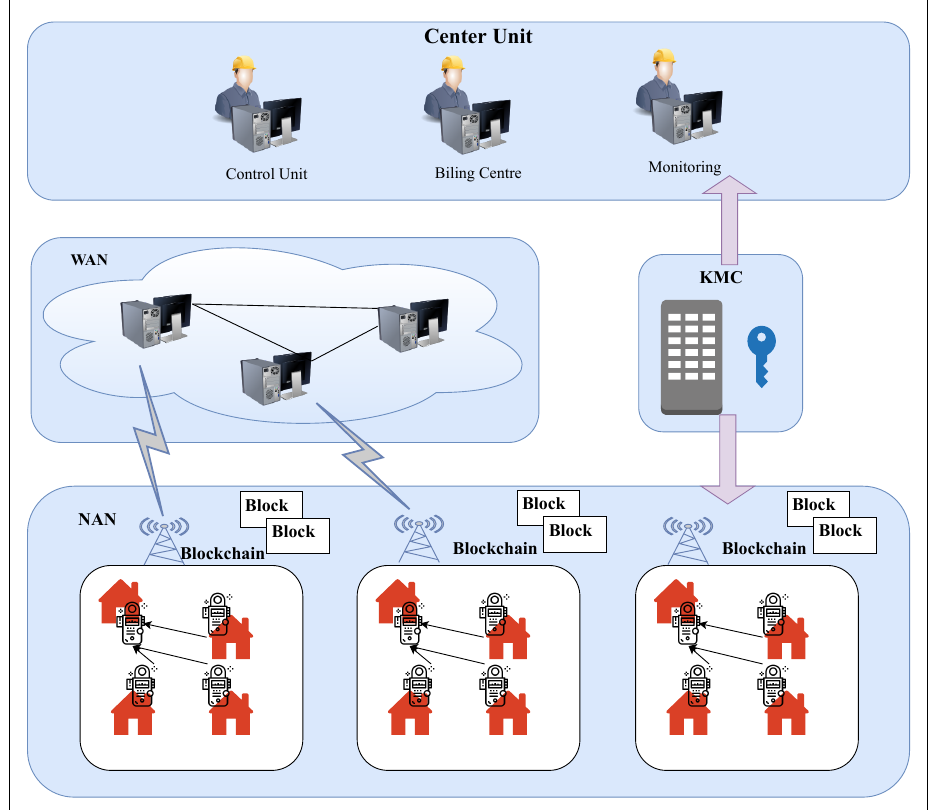
Figure 7. Architecture for data aggregation and privacy preservation